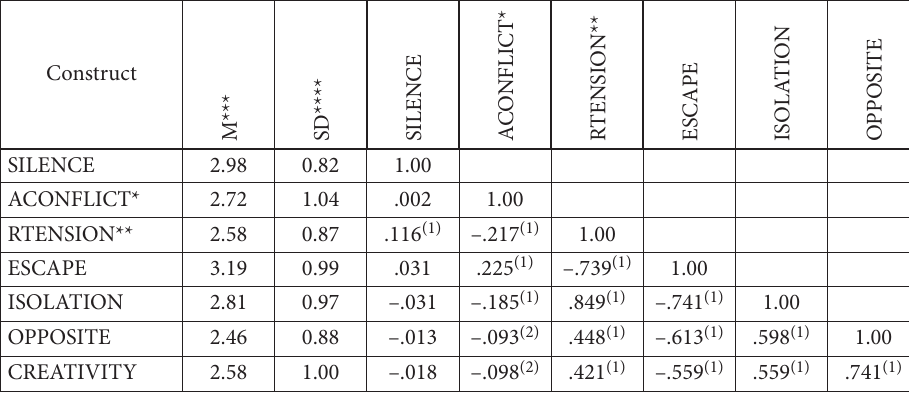
Table 2. Mean, standard deviation, and correlations (source: created by authors)